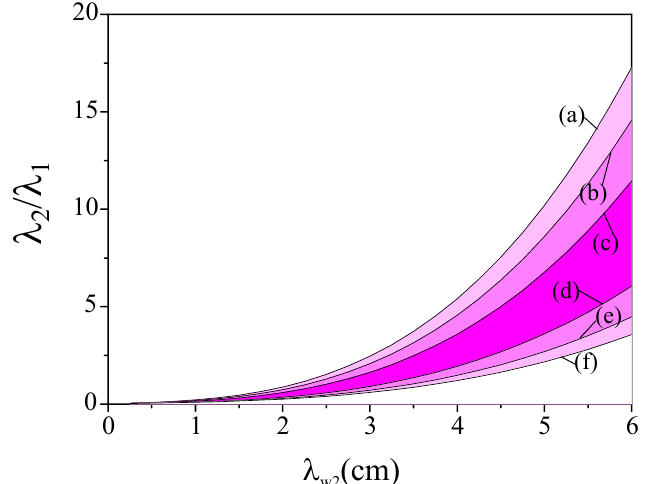
Figure 1. Ratio λ 2 / λ 1 as a function of the period of the second undulator module, fixing the first = 2.8 cm. The sequence of lines is obtained by scanning over the magnetic field values one to λ w 1 ( B 1 ( T ) , B 2 ( T ) ): a (0.75, 1.2), b (0.85, 1.2), c (1, 1.2), d (1.2, 1), e (1.2, 0.85), f (1.2, 0.75). The most efficient condition in terms of output power is represented by the darkest region, corresponding to large magnetic field values for both modules.